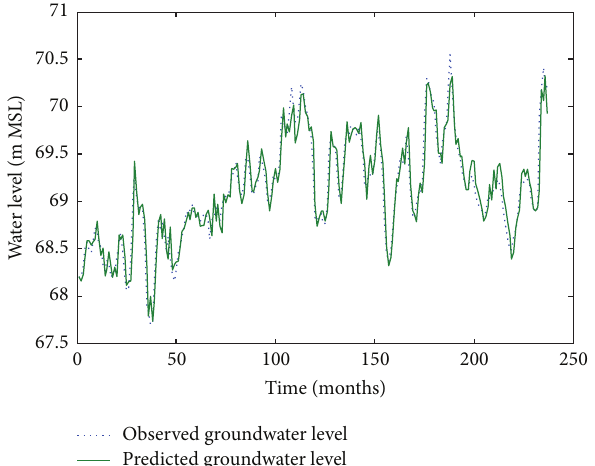
Figure 8: Comparison of observed groundwater levels with sim- ulated results for 1 month ahead using an ANN trained with the Levenberg–Marquardt algorithm (Pp 928).